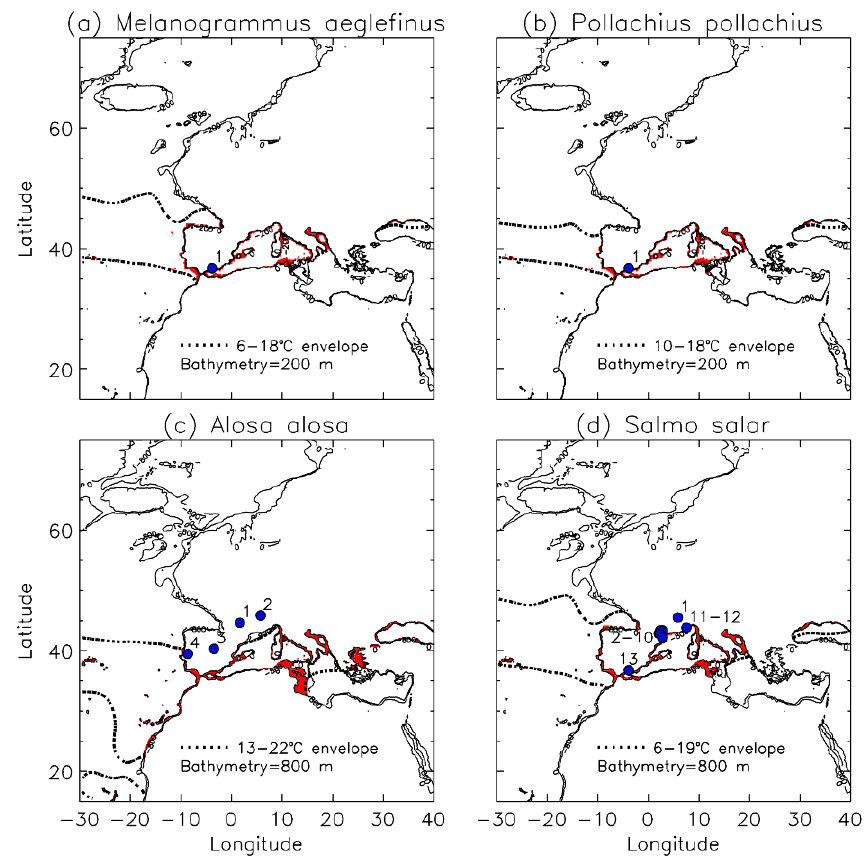
Figure 6. Predicted species ranges from the LGM reconstruction of Paul and Schäfer-Neth (2003) for (a) haddock, (b) pollock, (c) allis shad, and (d) Atlantic salmon. The ranges are based on the same criteria as for the present distribution in Fig. 3. The archaeological site key is the same as Fig. 3. The LGM ranges within the frame of these maps are 14–33% of the present day ranges, and the LGM distributions are almost completely shifted away from present-day ranges shown in Fig. 3. The LGM bathymetry is derived from the 1 ◦ sea level data of Peltier (1994) at 21ka before present, interpolated to the 5 0 fields of ETOPO-5. LGM sea level and the single additional bathymetric contour are indicated on the map.